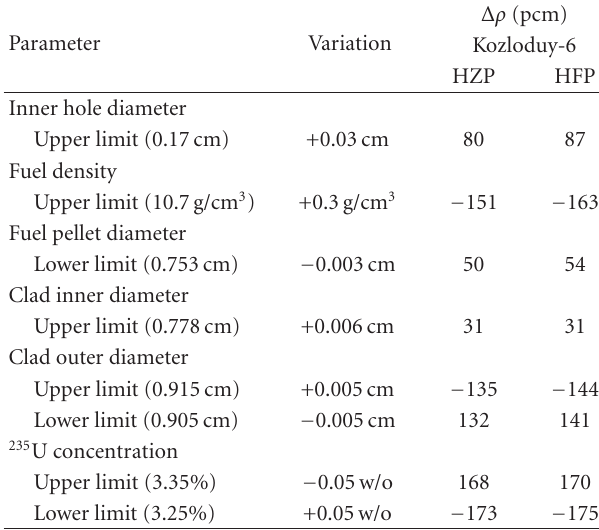
Table 8: Manufacturing sensitivities for Kozloduy-6 test case.